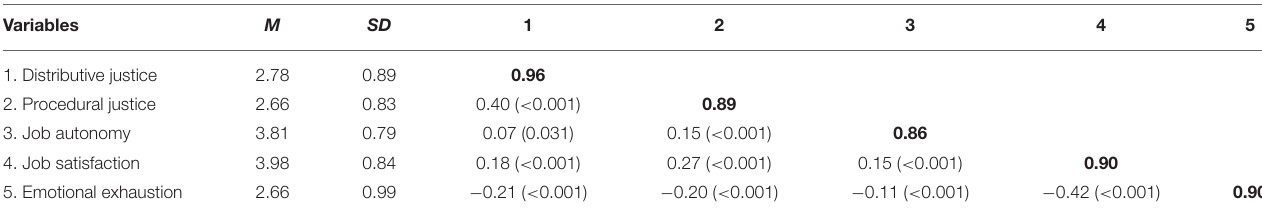
TABLE 5 | Means, standard deviations, intercorrelations, and Cronbach’s alpha coefficients of Study 2 variables.